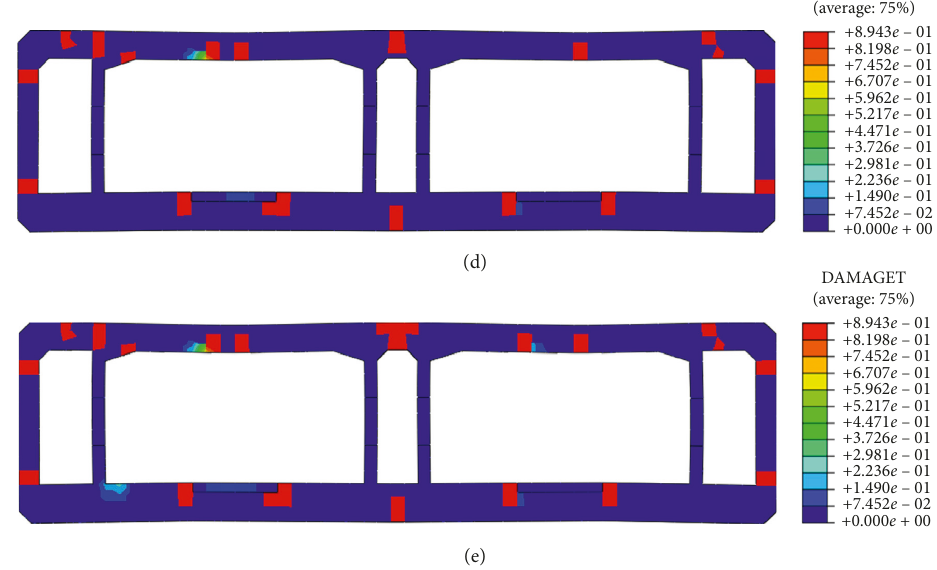
Figure 12: Crack distribution of joint cross section under incident angle (30 ° , 30 ° ). (a) t � 8s, (b) t � 10s, (c) t � 12s, (d) t � 16s, and (e) t �